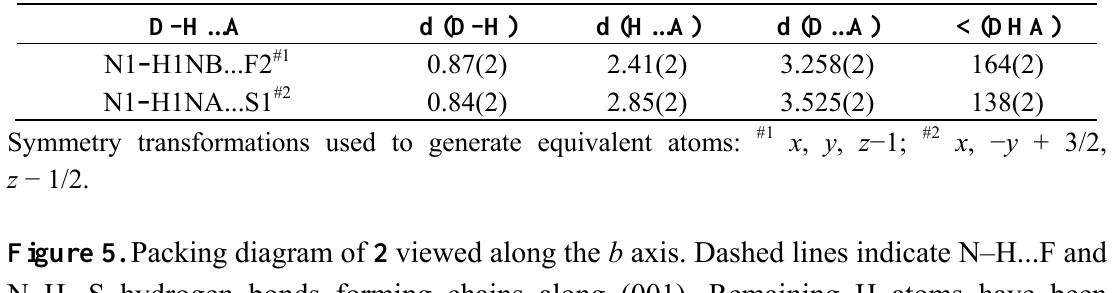
Table 3. Hydrogen bonds for 2 , C